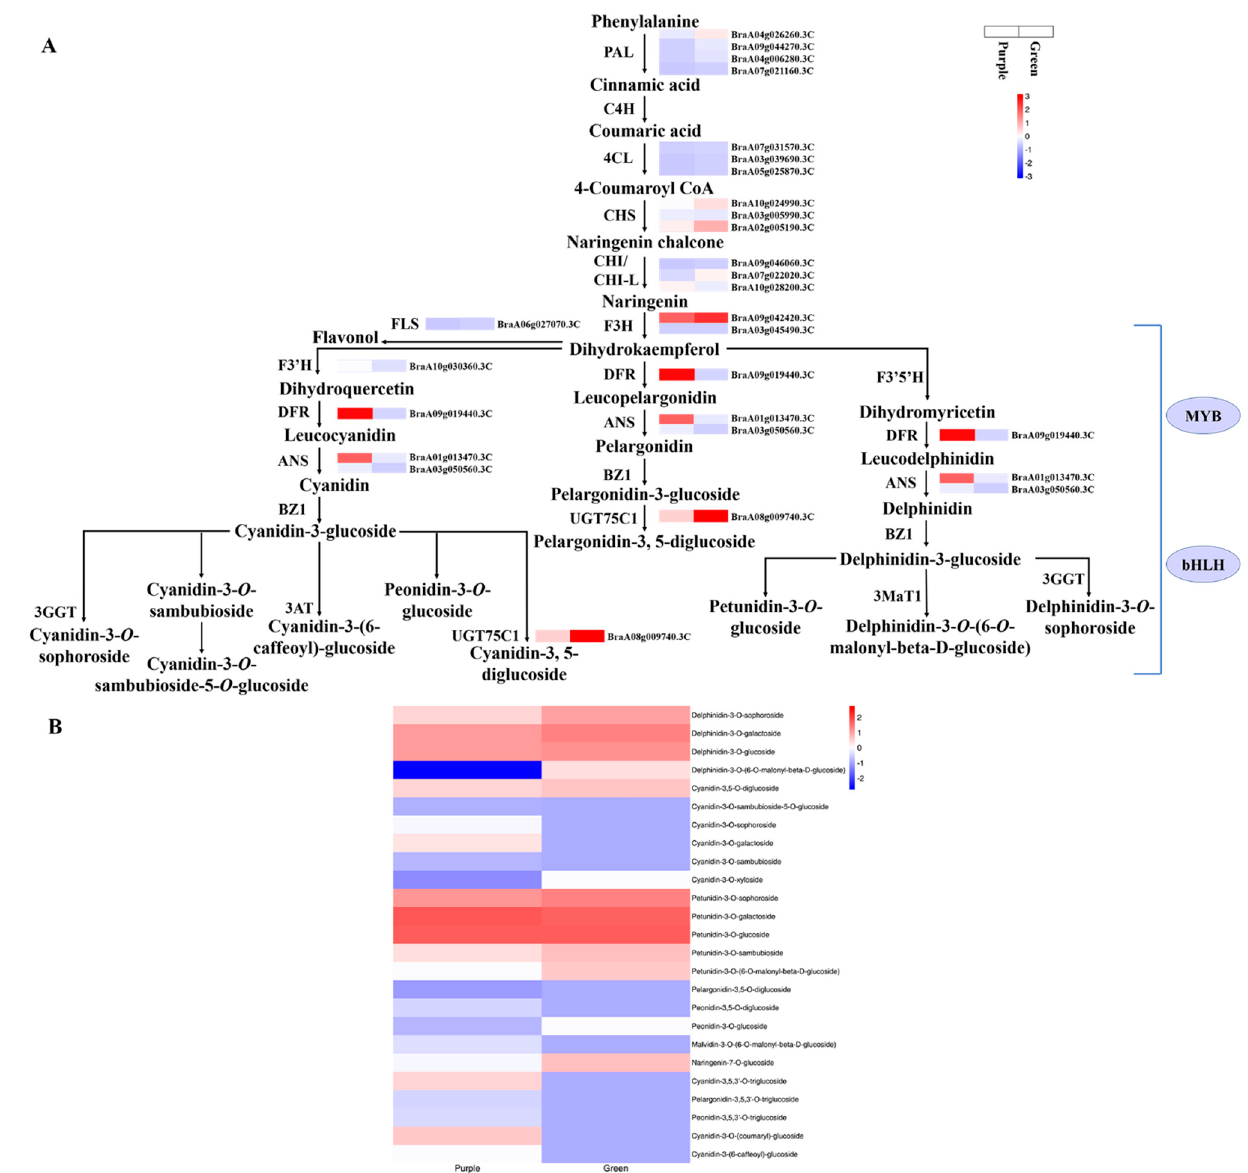
Figure 6. Transcript profiling of genes in the anthocyanin biosynthetic pathway in purple non-heading Chinese cabbage and its green mutant. ( A ) Reconstruction of anthocyanin biosynthetic pathway by differentially expressed structural genes and regulators. ( B ) Differentially accumulated metabo-